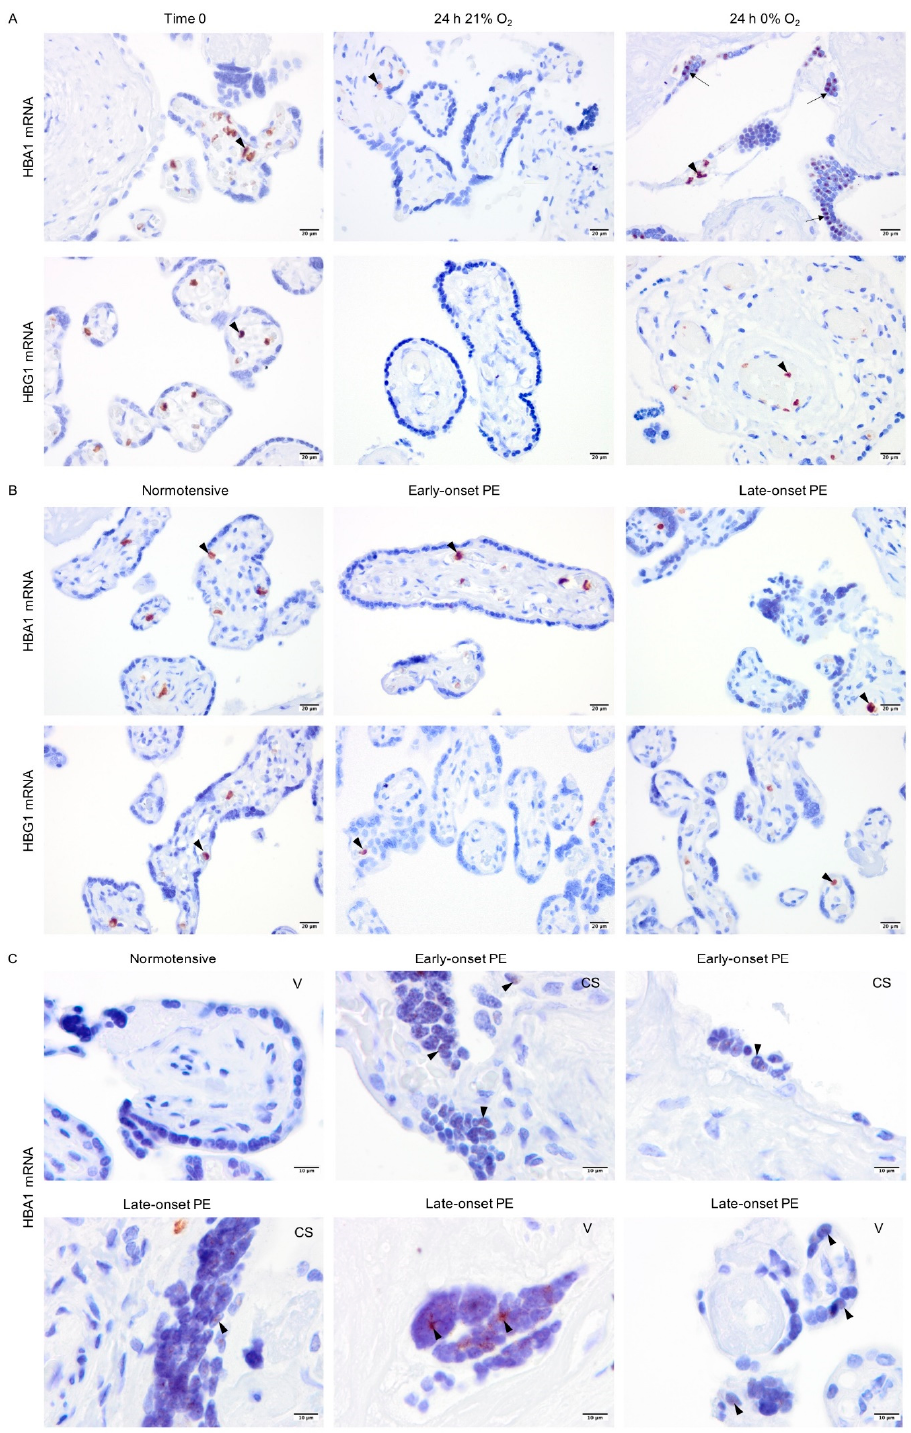
Figure 5. In situ analysis of alpha- and gamma-globin mRNAs. Alpha- and gamma-globin mRNAs were detected in erythrocytes in the placental vessels of cultured placental explants (arrowhead) ( A ). However, alpha-globin mRNA was also found in syncytiotrophoblasts of placenta explants cultured at 0% oxygen (arrow) ( A ). Alpha- and gamma-globin mRNAs were found in erythrocytes (arrowhead) in the placental vessels of placentas from both normotensive and PE pregnancies ( B ). Alpha-globin mRNA was also found sparsely in syncytiotrophoblasts (arrowhead) of placenta samples from early- and late-onset PE pregnancies independent of the mode of delivery; CS (cesarean section) or V (vaginal delivery) ( C ). Scale bar is 20 µ m for A and B, and 10 µ m for C. Images of negative control and placenta stroma are presented in Figures S1C and S2,